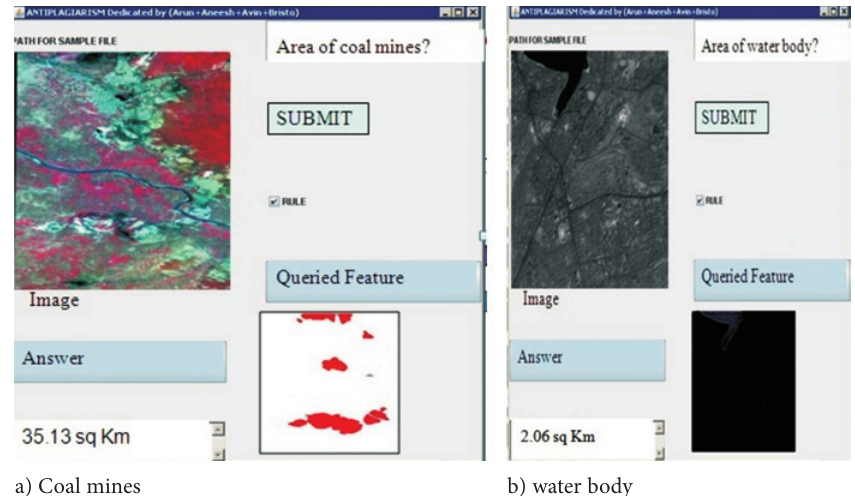
Fig. 3. Attribute specific